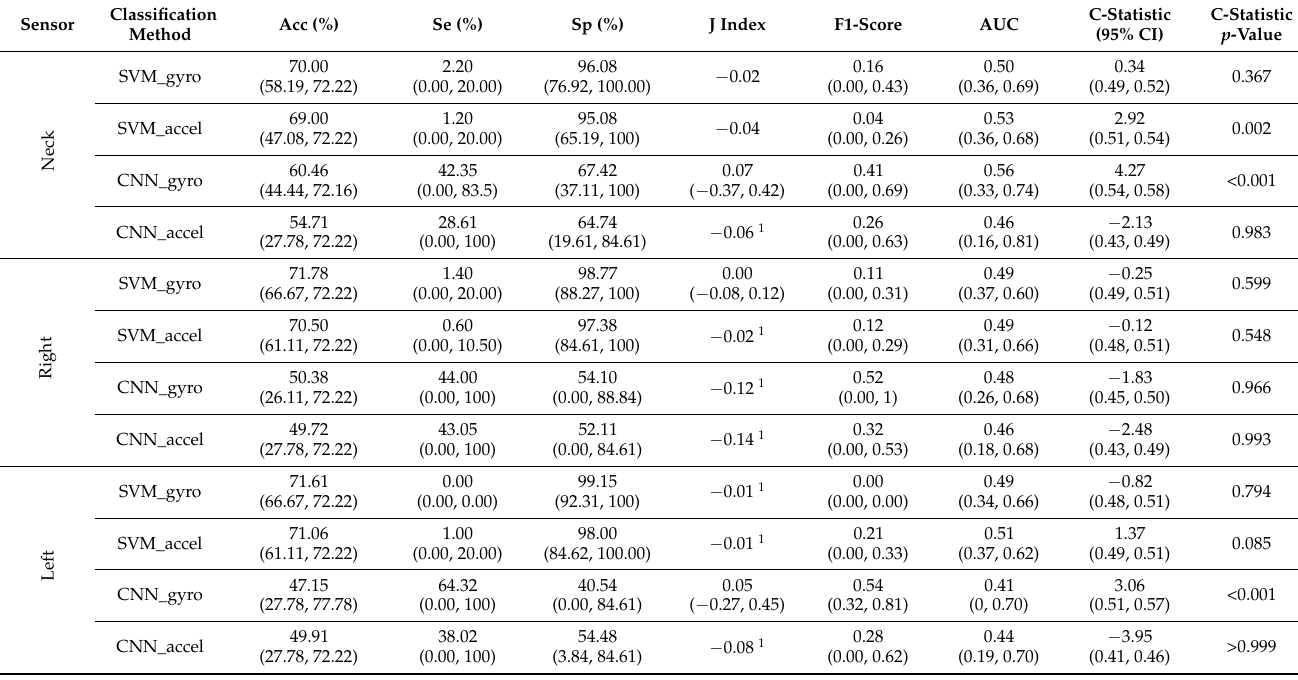
Table 5. The ML prediction of follow-up fall incidents for each sensor location using the TUG tests’ kinematics signals. Sensor Classification